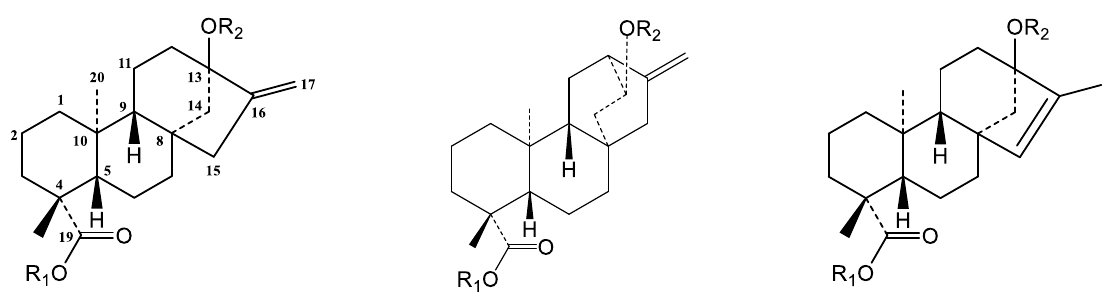
Figure 3. Chemical structures of steviol (I), hydroxyatisenoic acid (II) and endo -steviol aglycone (III).